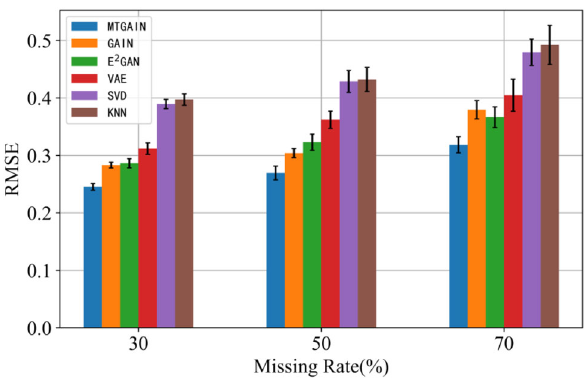
Fig. 9 RMSE comparisons in biased missing